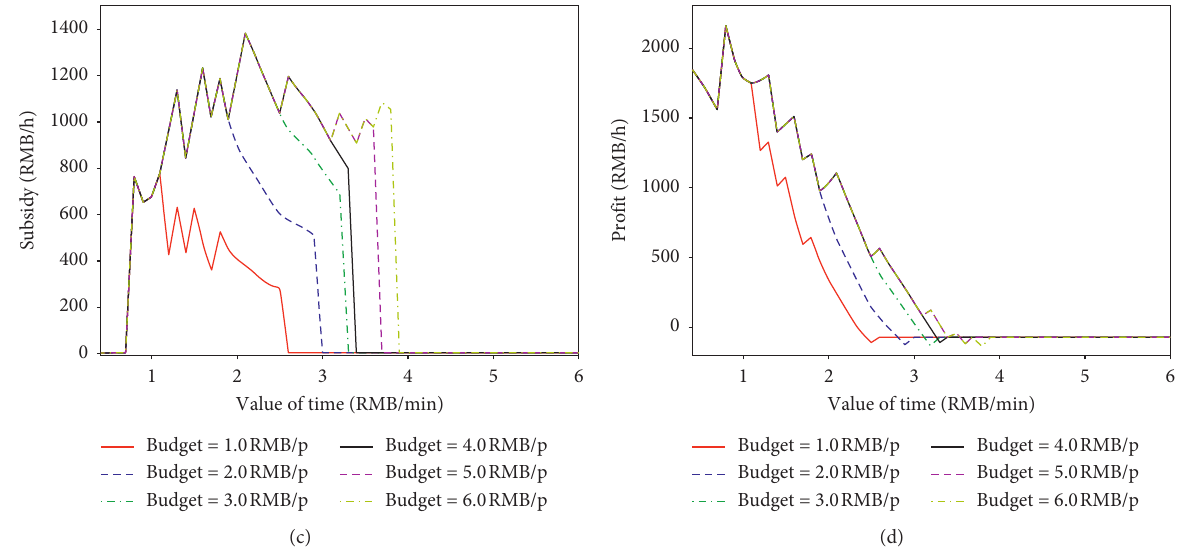
Figure 8: Variation of transit profit structure with VOT under different budget